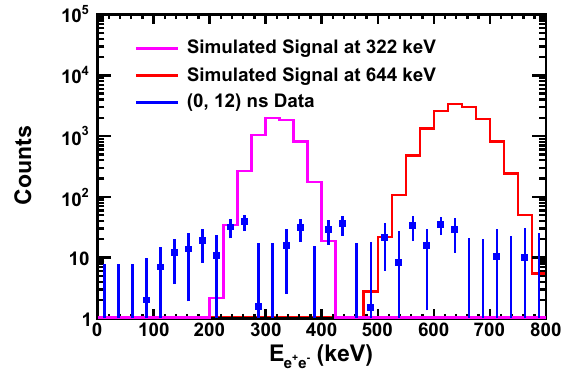
Figure 9. Background-subtracted e + e − pair kinetic energy spectra for events in our analysis time window (blue). For comparison, simulated positive dark matter decay signals at 322 keV (purple) and 644 keV (red) are overlaid. becoming 8% at 244 keV, and increasing to 60% at 144 keV.